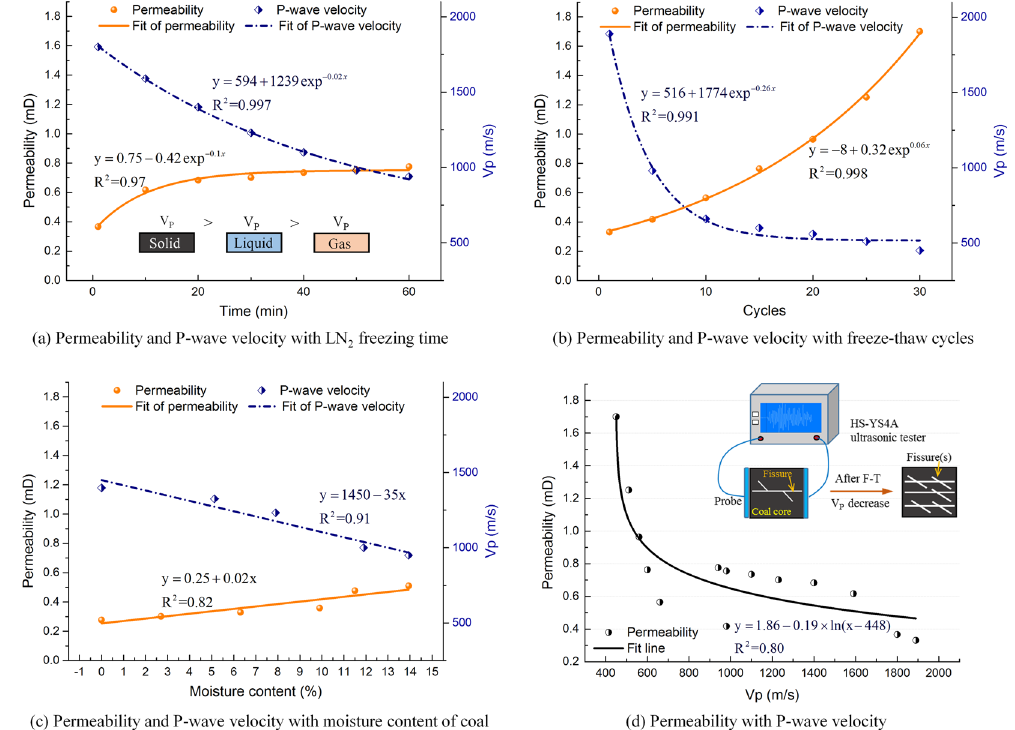
Figure 7. Graphs showing the correlation between longitudinal acoustic wave velocities and the permeability of coal subjected to different freeze-thaw